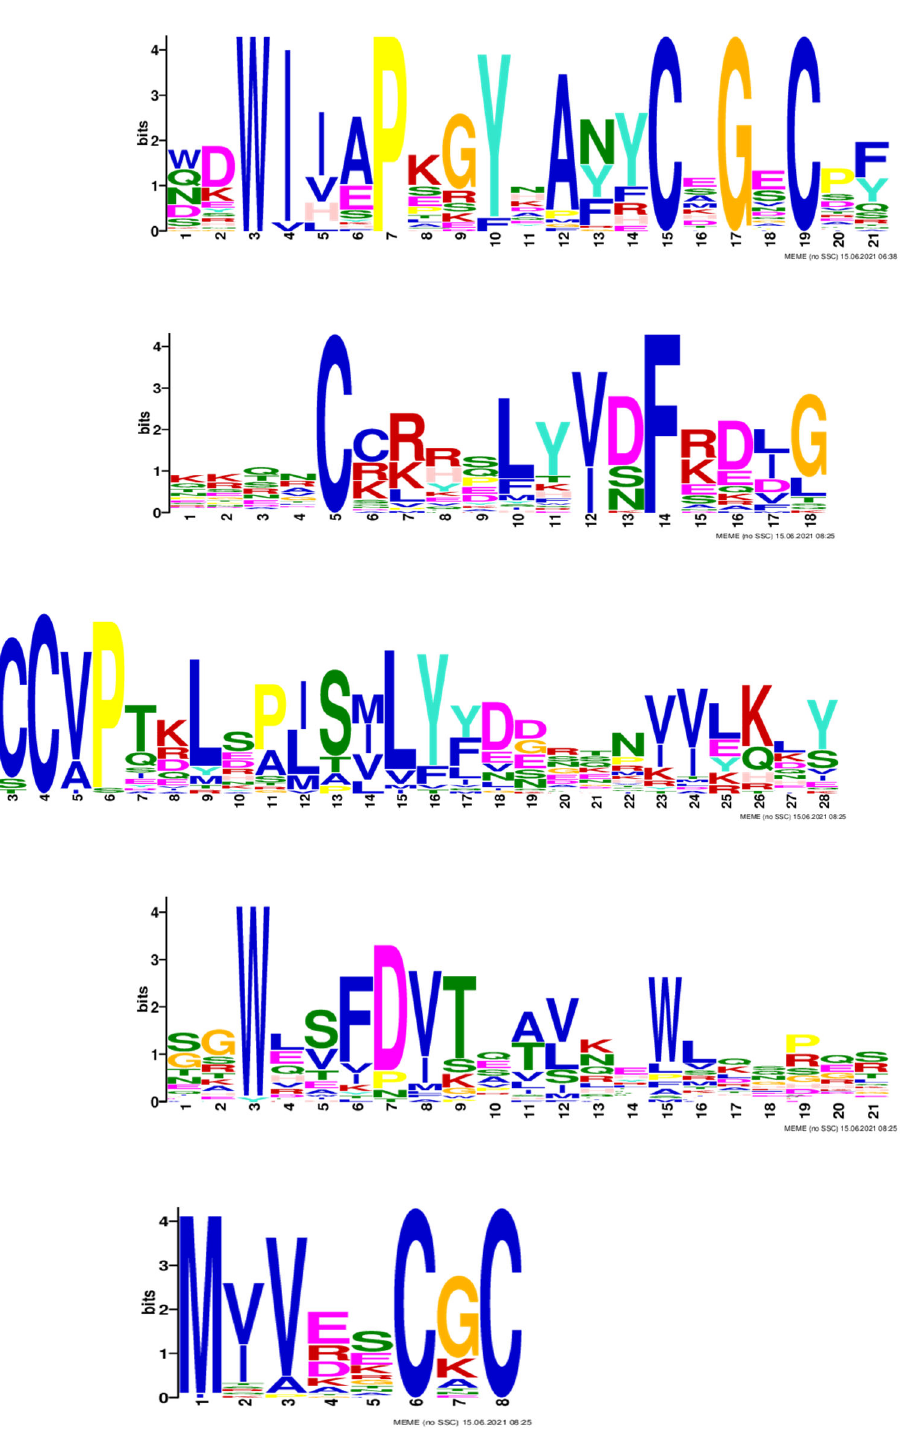
Figure 2. Sequence logo of five motifs predicted from the 38 BMP family proteins of zebrafish. Cys- teine, glycine, and phenylalanine residues were identified to be prominent in the motifs.